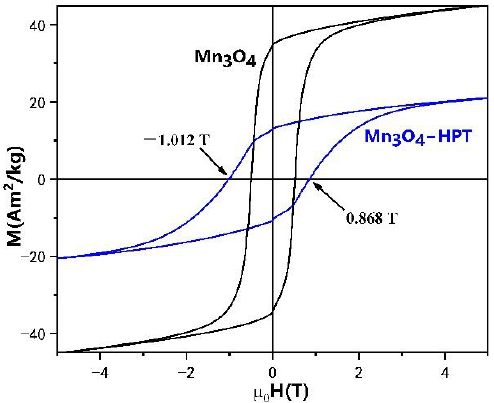
Figure 6. Magnetic hysteresis loops of the HPT Mn 3 O 4 and Mn 3 O 4 precursor measured at 5 K.